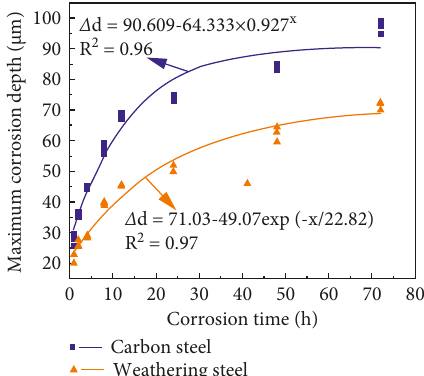
Figure 7: Relationship between Δ d and corrosion